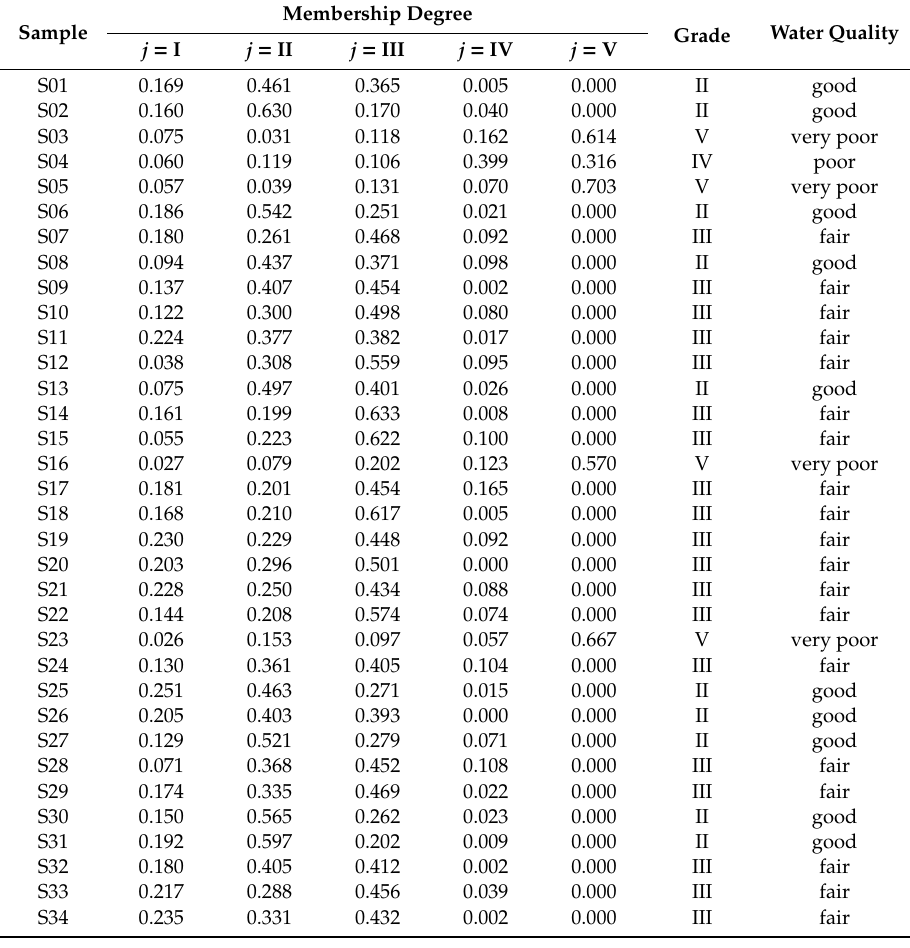
Table 3. Assessment results of shallow groundwater quality based on fuzzy comprehensive